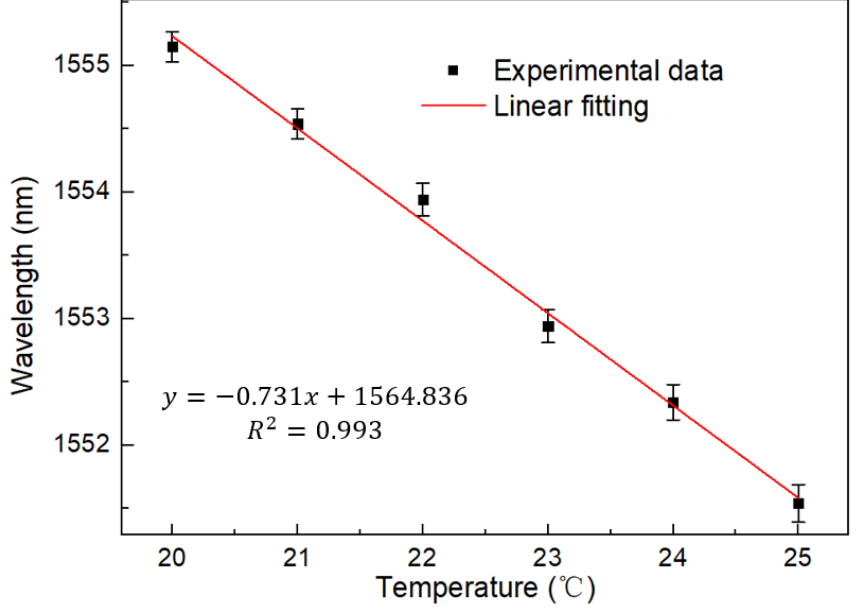
Figure 7. Linear fitting curve of wavelength and temperature of a single Saganc ring at 20–25 °C .